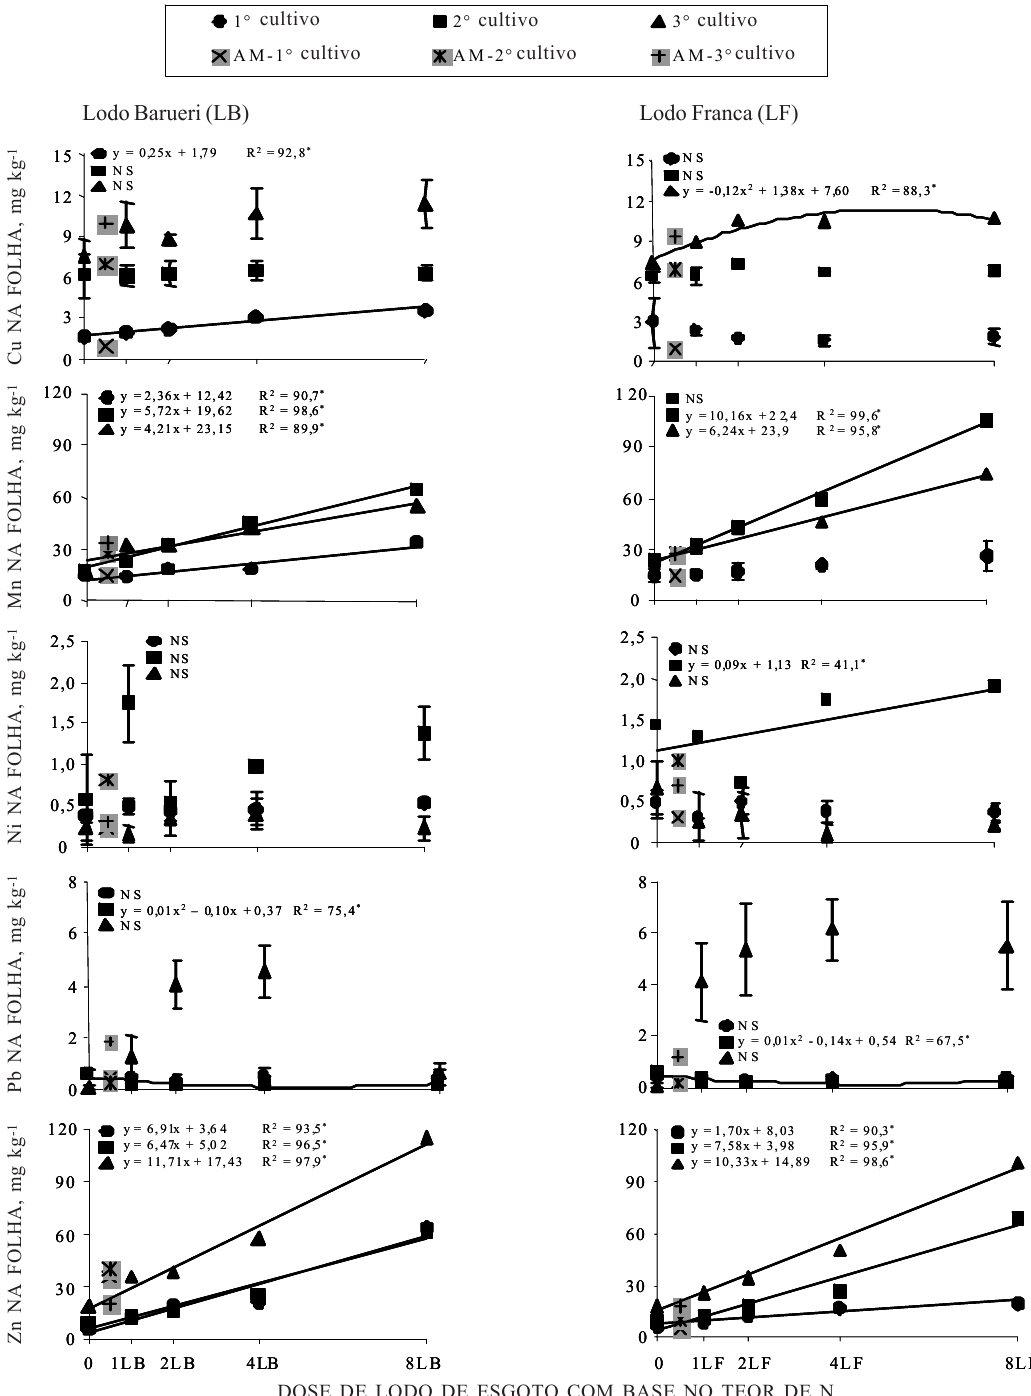
Figura 1. Efeito de diferentes fontes e doses de lodo de esgoto sobre os teores de Cu, Mn, Ni, Pb e Zn em folhas de milho, em três cultivos consecutivos (* Modelo ajustado significativo a p ≤≤≤≤≤ 0,05 pelo teste F; NS - não-significativo; AM = adubação mineral com NPK recomendada para a cultura do milho). As barras verticais referem-se ao desvio-padrão da